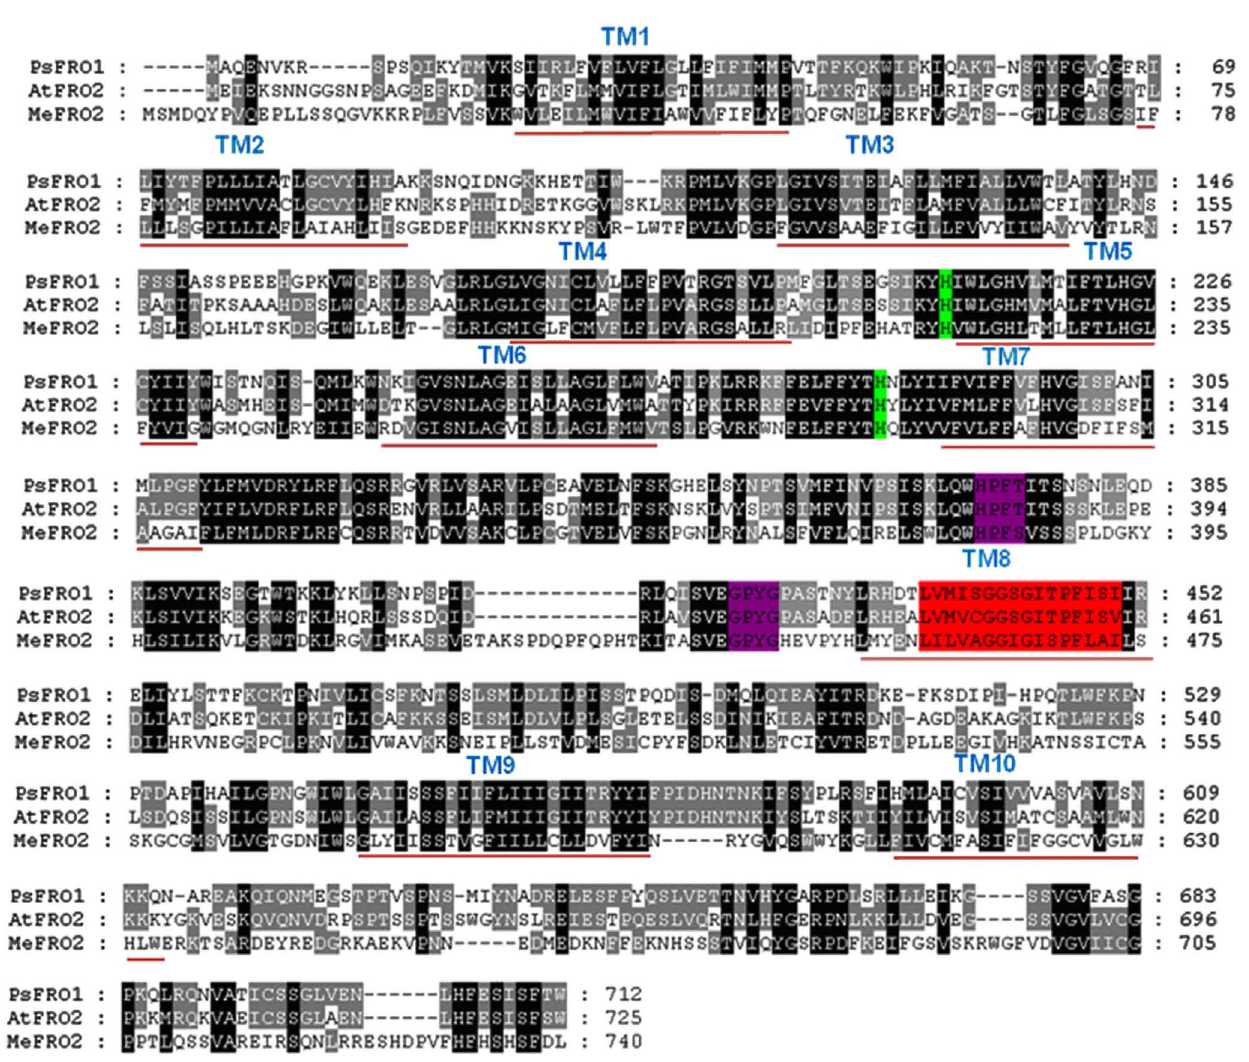
FIGUREA3 | Comparison of the putative amino acid sequences of MeFRO and other plant FRO proteins. Identical and conservative amino acids are shaded in black and gray, respectively. Dashes indicate gaps.Ten transmembrane domains (TM) were identified usingTMHMM and are shown as red lines below the sequences. Conserved histidines involved in heme